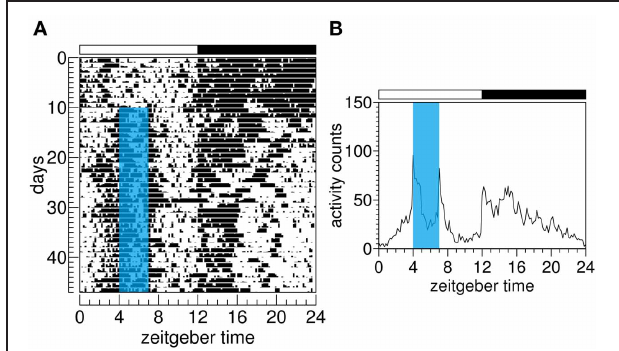
FIGURE 1 | Food anticipatory activity of one Wistar rat. (A) Actogram shows the motor activity rhythm. In this type of representation, xy graphs (time/activity bouts) are plotted from the top to the bottom, representing subsequent days. Zeitgeber time refers to the time of the light–dark cycle. By convention, zeitgeber time 0 denotes light onset while zeitgeber time 12 denotes dark onset in a 12h:12h cycle. (B) Waveform depicts averaged activity over 37 days of scheduled feeding. Blue area on A and B indicates chow availability for 3h each day. Food anticipatory activity is seen in both actogram and waveform